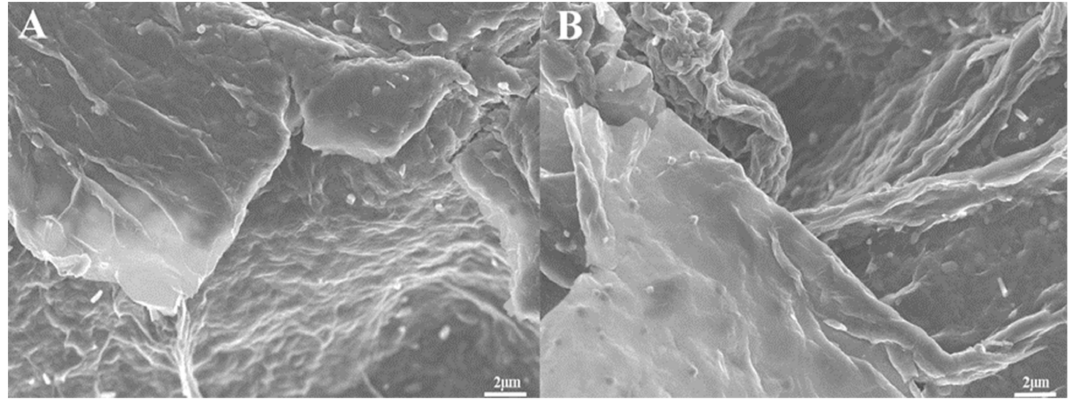
Figure 6. SEM image ( A , B ) of rGO-NS-Ni composite with the magnifications were 5 k. In order to investigate the existence state of each element in rGO-NS-Ni, and probe the catalytic mechanism in DGAFC, XPS spectra were measured (Figure 7A–E). In C1s spectrum, there were four peaks, which correspond to non-oxidized carbon C-C (284.12 eV), carbon atom in C-O group (284.87 eV, epoxy or hydroxyl), carbonyl carbon C=O (287.03 eV), and carboxyl carbon O-C=O (288.5 eV), respectively. The non-oxidized carbon C-C accounted for the highest proportion obviously. In addition to non-oxidized carbon, there were carbonyl carbons, carboxyl carbons, and other oxidized carbons, indicating that pristine GO existed in rGO-NS-Ni. The existence of a small amount of GO in rGO was reasonable due to the uncompleted reduction. In the N 1S spectrum of the XPS (Figure 7B), rGO-NS-Ni had three peaks, corresponding to pyridine nitrogen (397.11 eV), pyrrole nitrogen (399.22 eV) and graphite nitrogen (400.67 eV), respectively. The structure of these nitrogen elements in rGO-NS-Ni was that the pyridine nitrogen combines with two carbon atoms, and one of the p electrons was located in the p conjugated system so that the pyrrole nitrogen is accompanied by a pair of p electrons [47]. Graphite nitrogen represents nitrogen atoms that replace carbon atoms in the hexagonal ring in graphene [48]. Figure 7C shows the details of high-resolution spectrum of Ni 2p, which could be fitted into two states peaks. For Ni2p 3/2 and Ni2p 1/2 , binding energies were placed at 858.73 and 857.87 eV ± 0.2 eV, respectively. The pair of binding energies existed at 857.11, 858.97 and 857.78 eV were attributed to Ni 3+ , and the other pair at the energies of 874.31 and 862.09 eV was corresponding to Ni 2+ . They represent Ni 3+ in NiOOH and Ni 2+ in Ni-O and Ni (OH) 2 , respectively. In addition to these five peaks, the remaining five peaks were all satellite peaks, and their corresponding binding energies were 860.5, 880.67, 866.24, 863.97 and 877.64 eV, respectively. In the S2p spectrum (Figure 7E), there were two types of S species located at 162.6 eV and 161.44 eV, with a splitting energy of 1.16 eV, corresponding to C-S-C and -C=S-, respectively. The strong peak near 168.35 eV can also be attributed